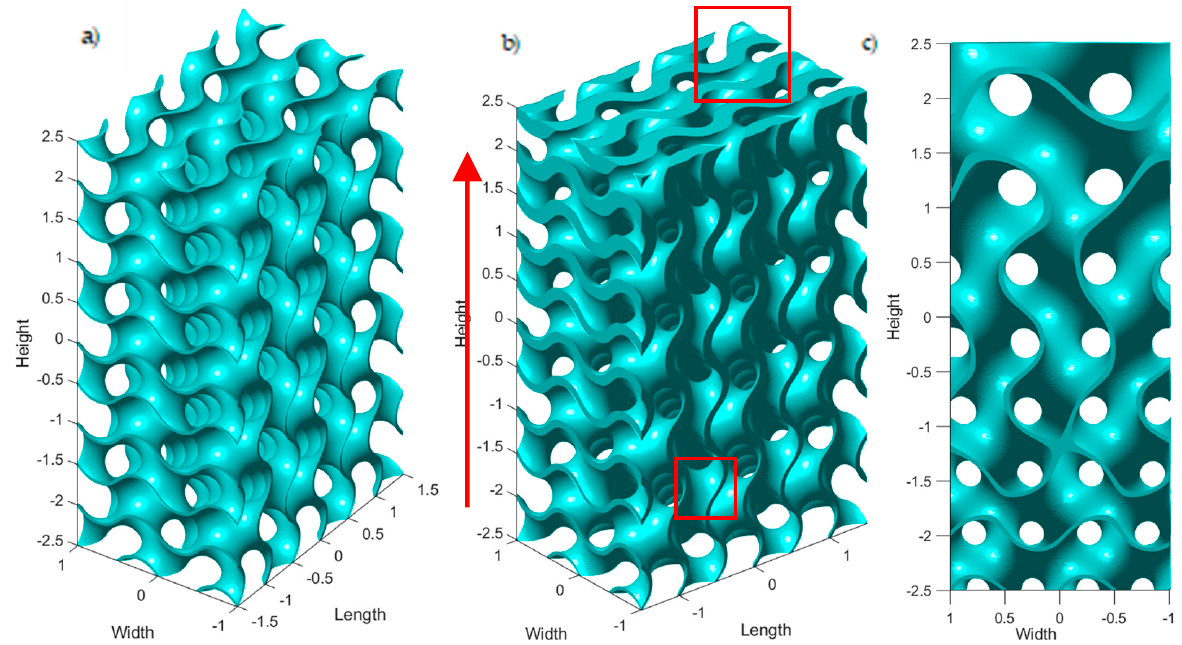
Figure 5. The structure of TPMS (gyroid) with dimensions 2 × 3 × 5: ( a ) homogeneous structure, ( b ) relative density increases from 10% to 50%, ( c ) the size of the elementary cell of the minimal area increases twice (relative density—10%).